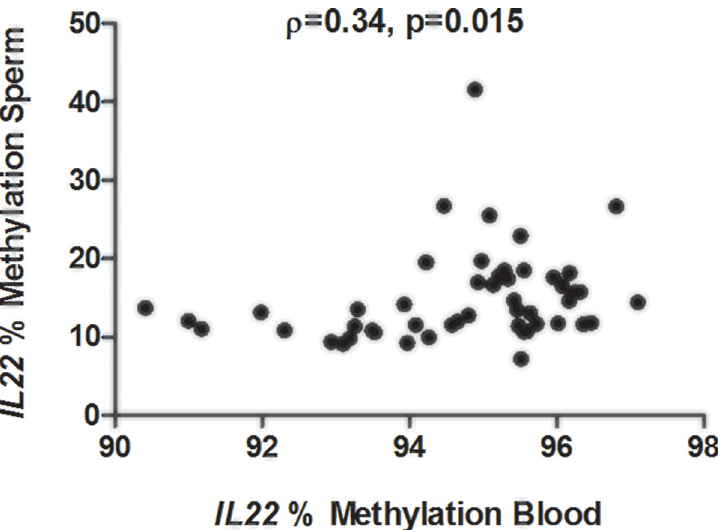
Fig 4. Correlation between sperm and blood methylation of IL22 . Methylation of exon 1 of IL22 was significantly correlated across sperm and blood samples, as measured by Infinium arrays (sperm) and pyrosequencing (blood).